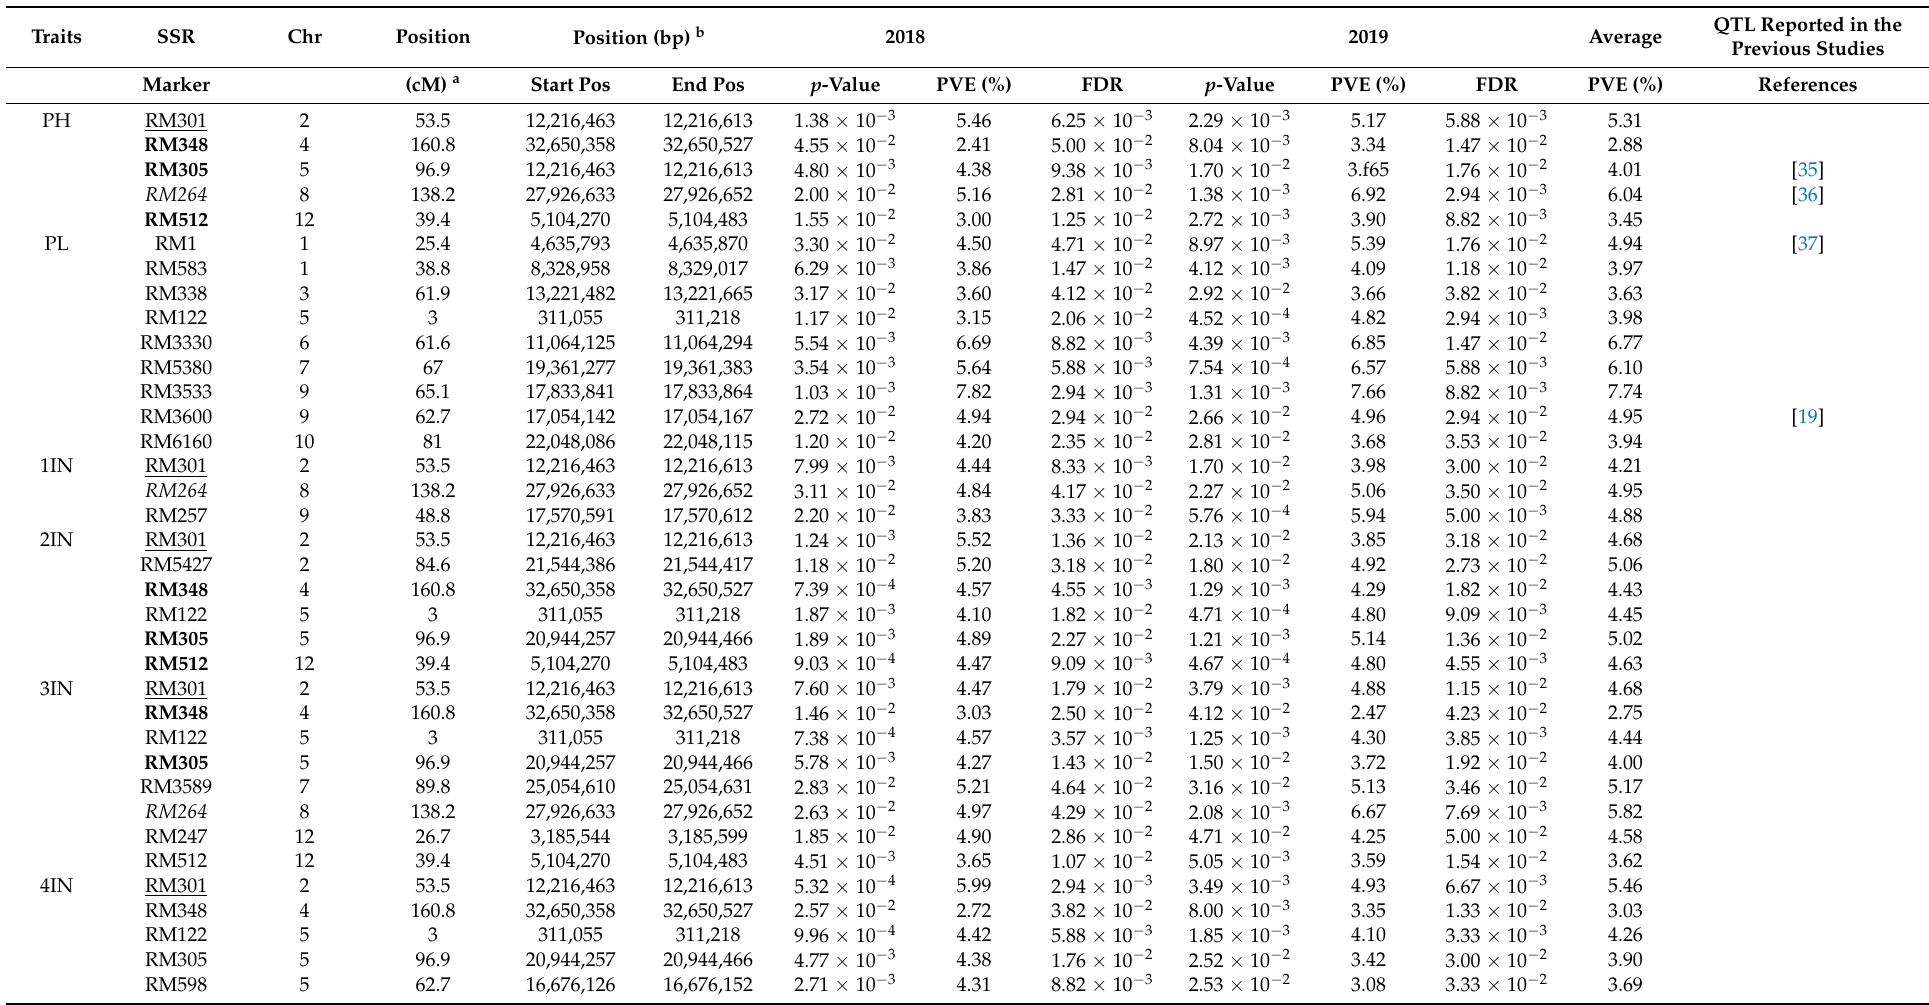
Table 3. Marker–trait associations with p -value < 0.05, their equivalent false discovery rate probability (FDR), proportion of phenotypic variance explained (PVE) and marker position on chromosome derived from 262 markers and 474 rice accessions detected in two